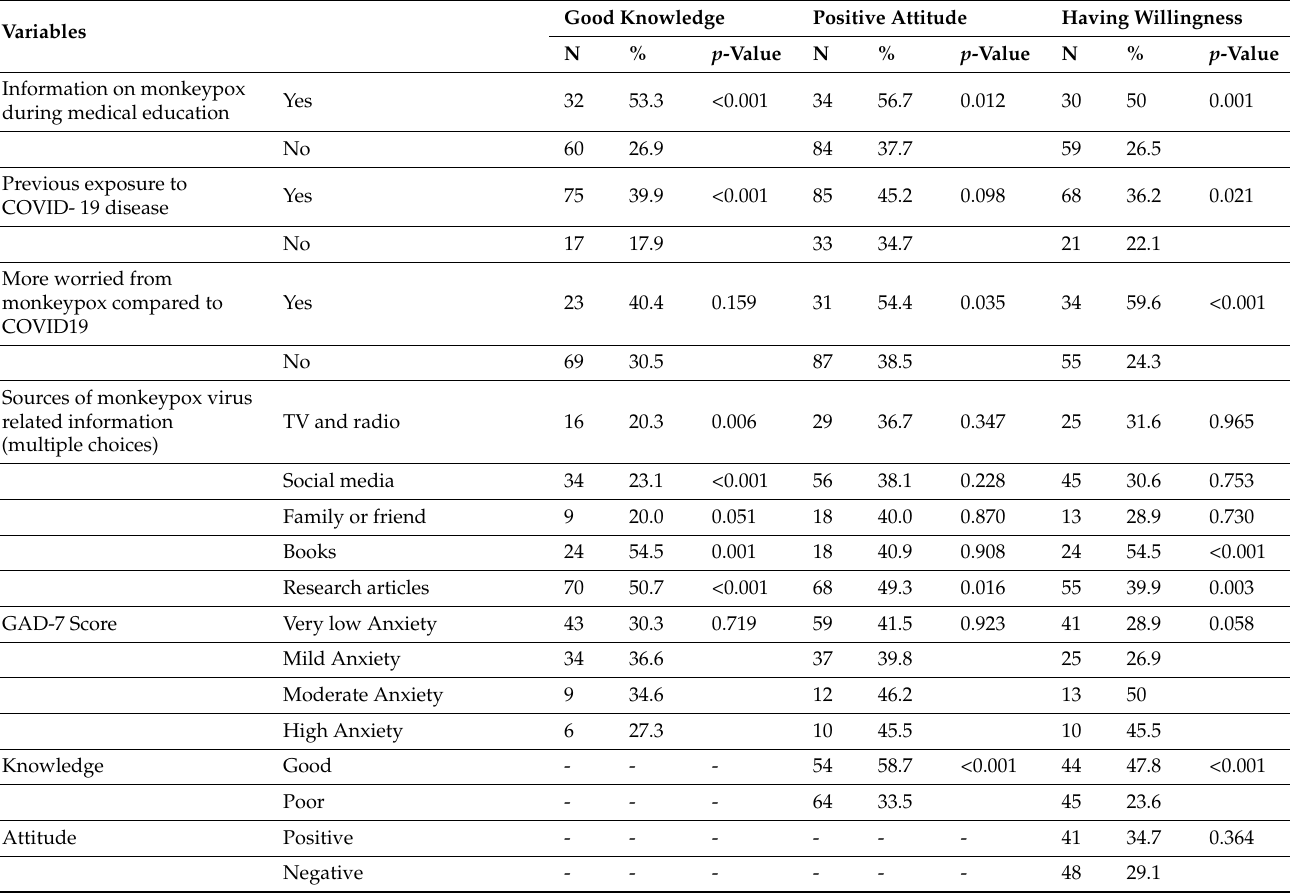
Abbreviations: GAD-7, General Anxiety